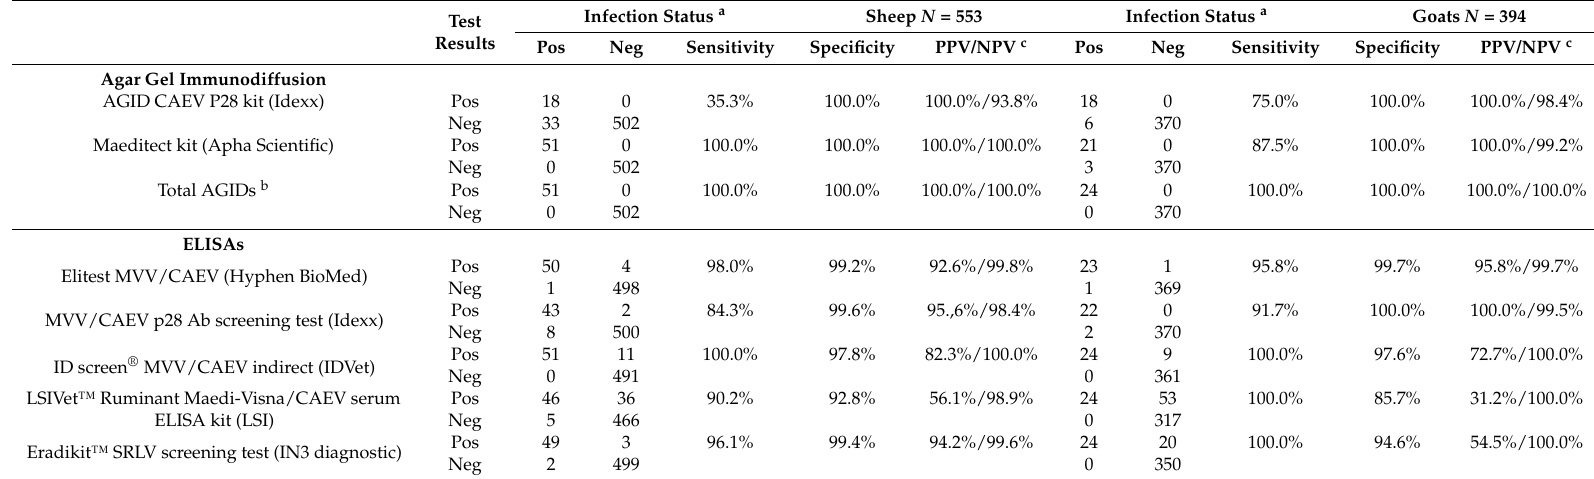
Table 2. 2 × 2 contingency tables summarizing individual kit serological test results compared to the defined infection status and derived sensitivity, specificity, and negative/positive predictive values for each